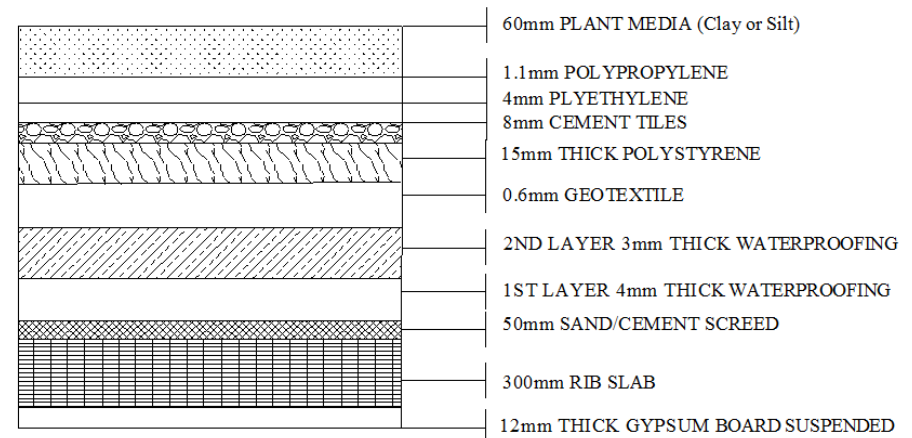
Figure 4. Cross section of roof component construction in DesignBuilder program with vegetation.